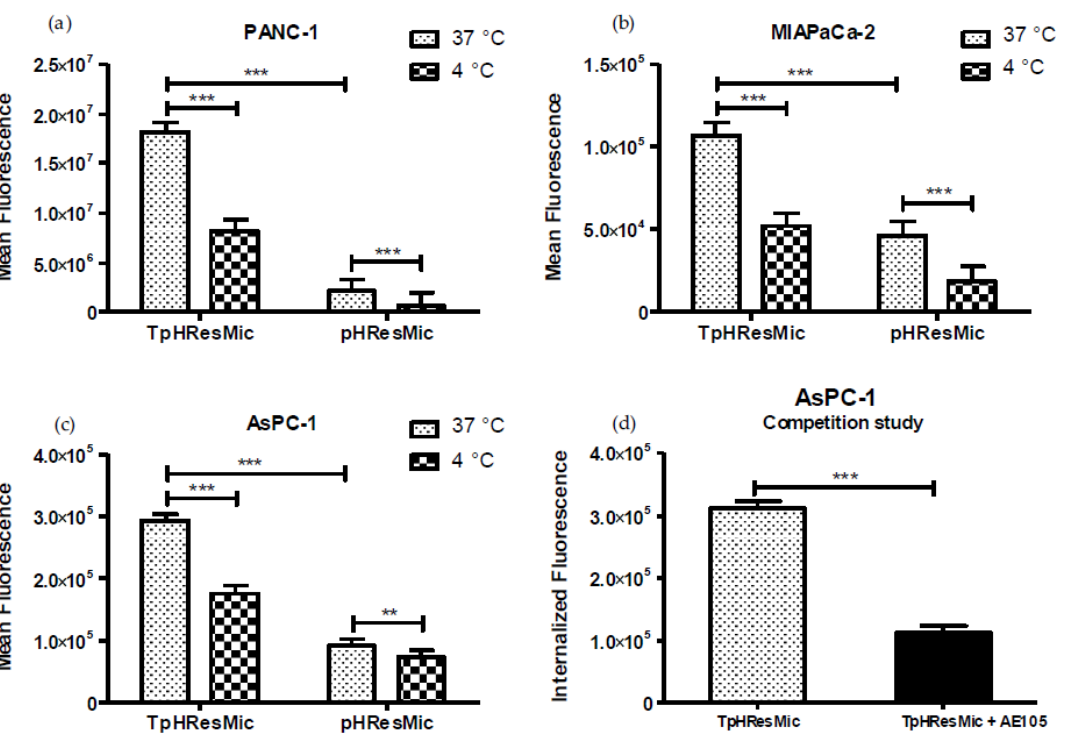
Figure 8. ( a – c ) Uptake studies of the targeted (TpHResMic) and no targeted micelles (pHResMic) on 2D model of PDAC cells. The histogram plots report the mean fluorescence values obtained after incubation for 1 h of PDAC cells with BDP@TpHResMic and BDP@pHResMic at pH 6.8 medium and at 37 °C or 4 °C, and refer to three independent experiments. ( d ) The histogram plots report the